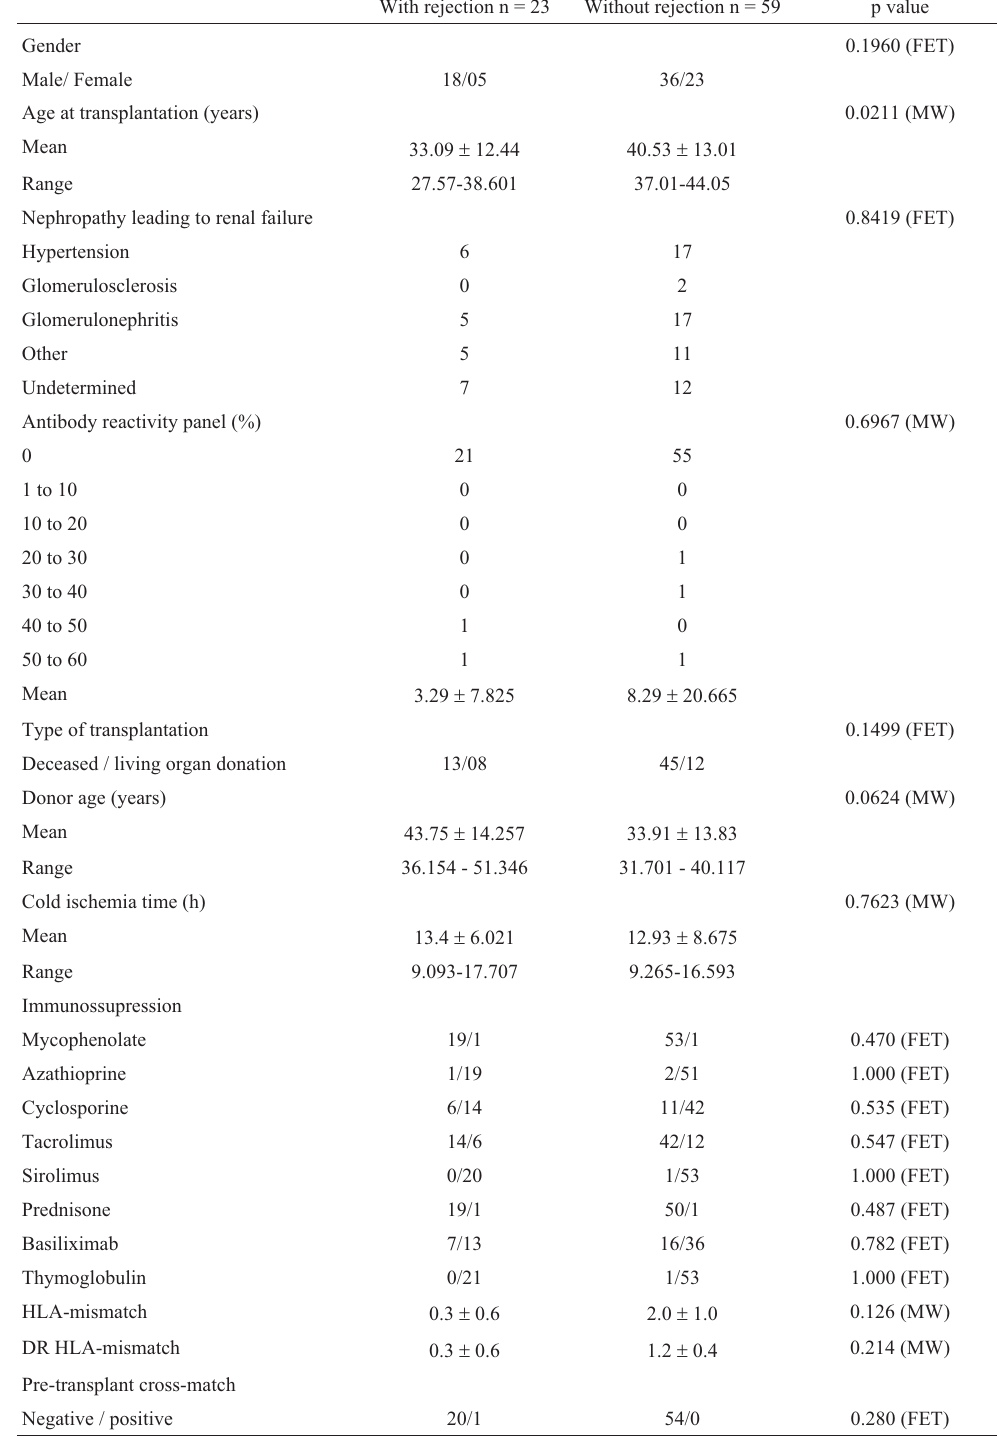
Table 1 - Demographic, clinical, laboratorial and histopathological features of kidney transplant